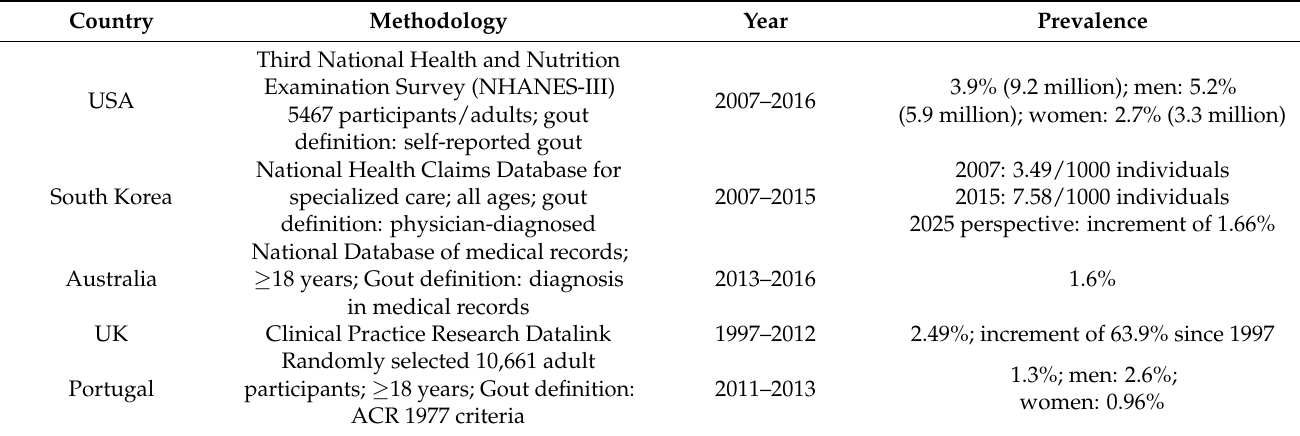
Table 4. Gout prevalence at a global scale (data given in the studies from References